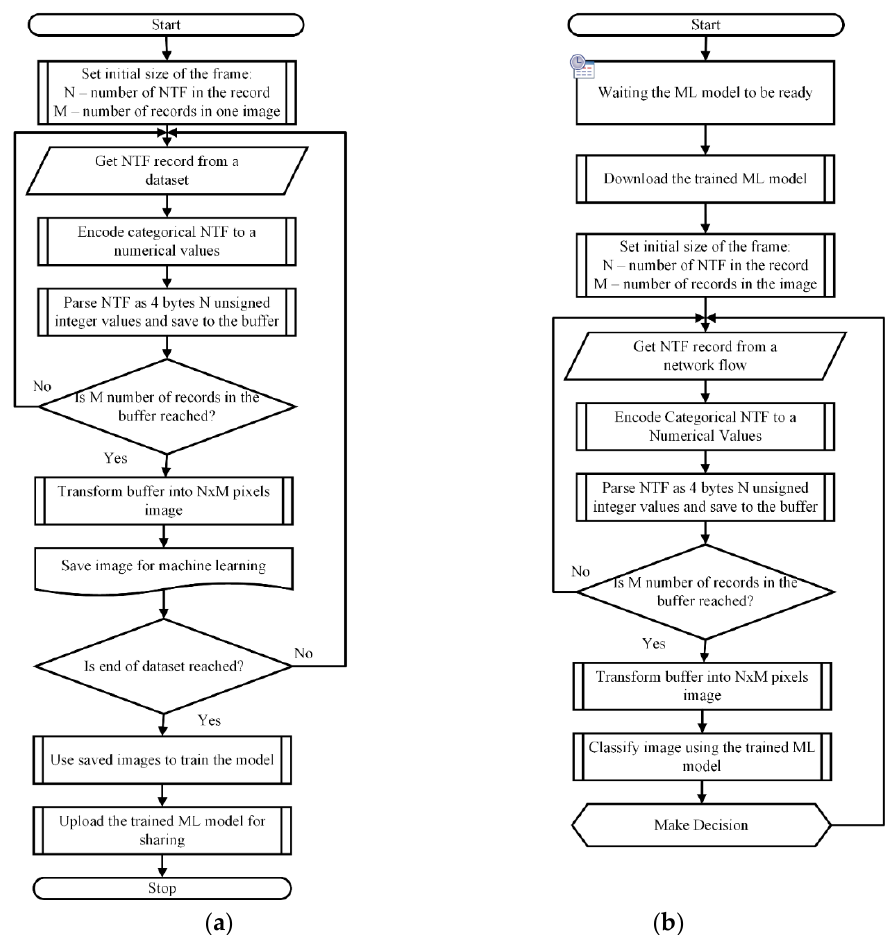
Figure 2. The proposed method for framing records of NTF and representing frames as images: ( a ) Training phase; ( b ) Detection phase.